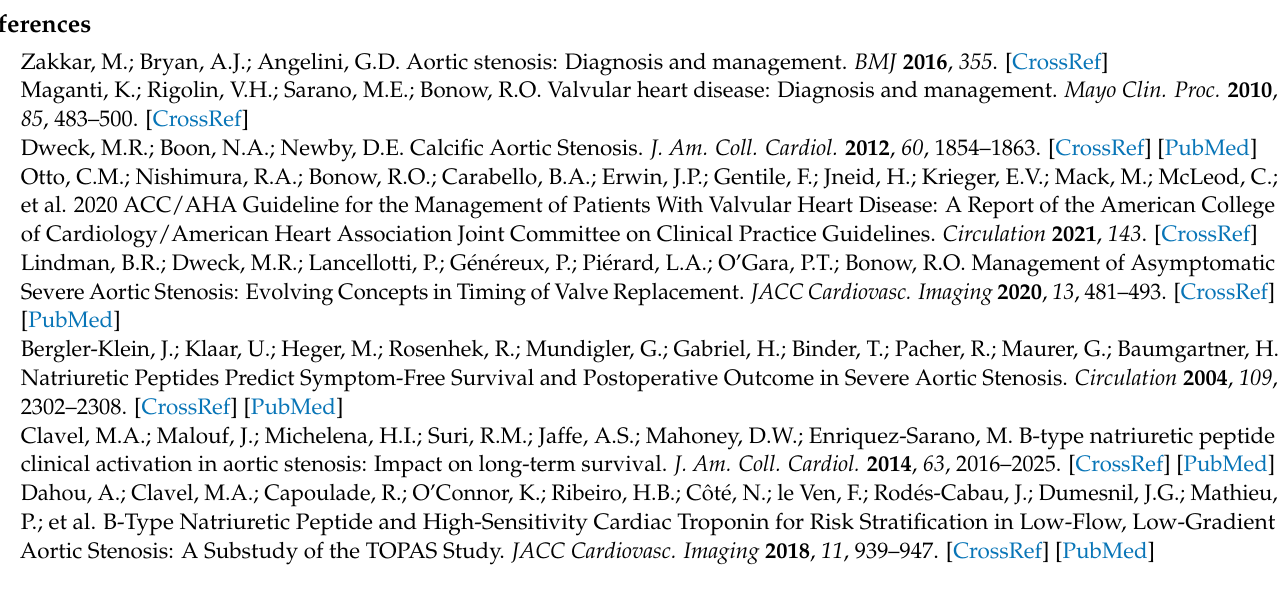
Figure S3: Funnel plots for BNP and NT-proBNP meta-analyses, Figure S4: Funnel plot for Troponin meta-analysis, Figure S5: Funnel plot of Galectin-3 meta-analysis, Table S1: Characteristics of included studies reporting BNP, Table S2: Characteristics of included studies reporting NT-proBNP, Table S3: Newcastle-Ottawa Scale quality assessment for included studies, Table S4: Characteristics of included studies reporting Troponin, Table S5: Characteristics of including studies reporting Galectin-3, Table S6: Characteristics of included studies reporting other